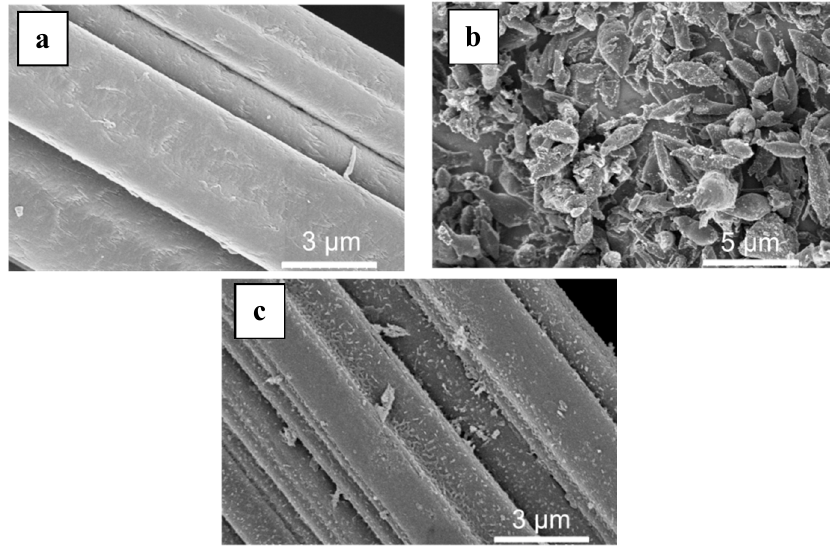
Figure 1. SEM of ( a ) raw carbon felt (CF), ( b ) CF covered with grown MIL-53(Fe) particles, ( c ) final Fe-MOFs@CF800/5h electrode.